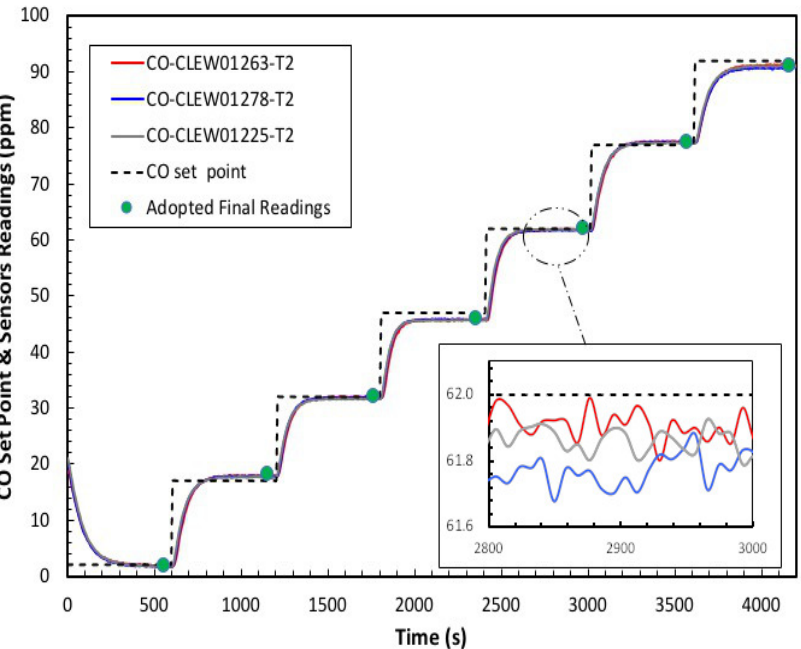
Figure 14. CO set points and sensors detected CO concentration after calibration (ppm).